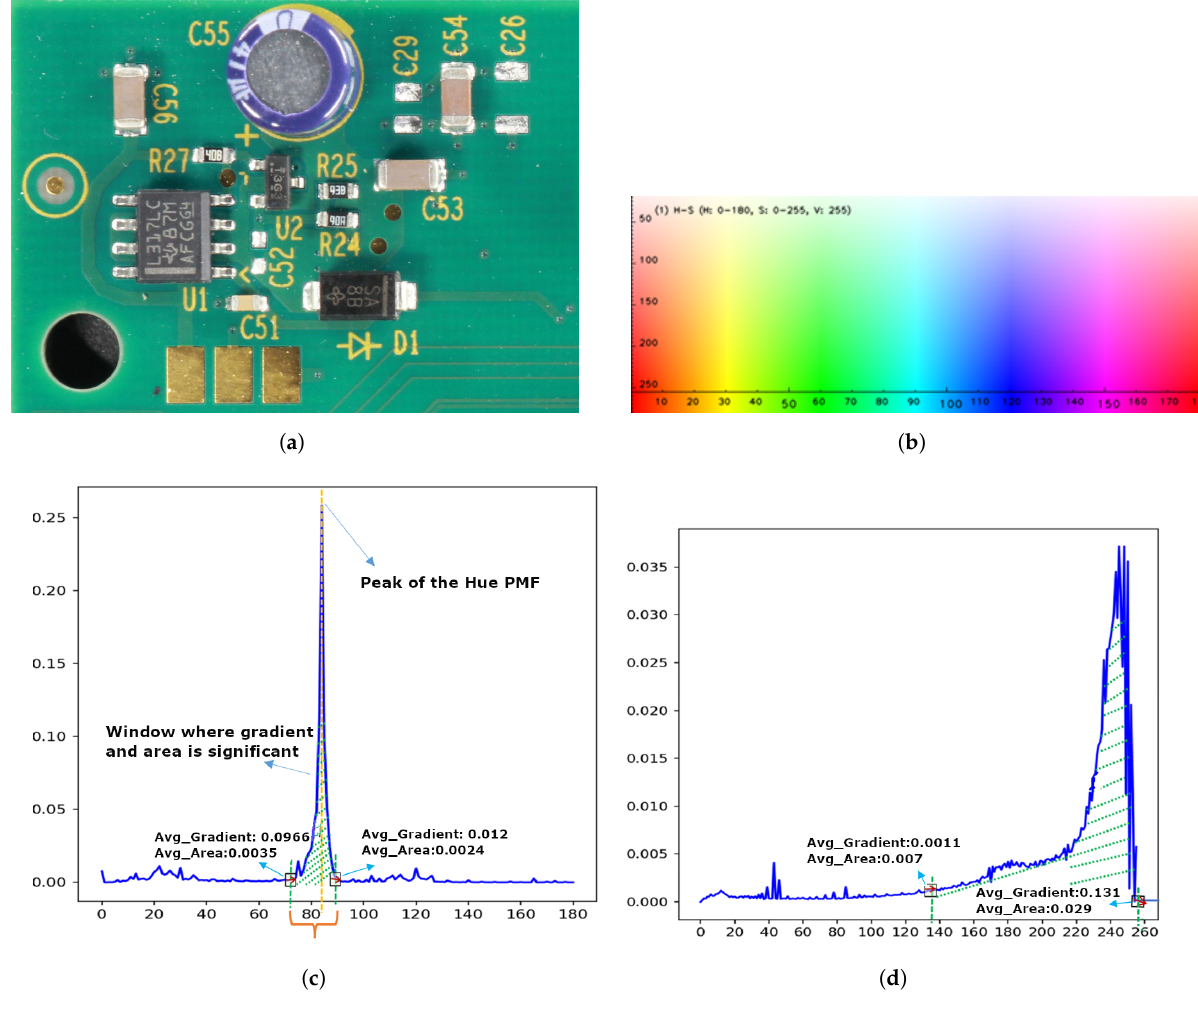
Figure 2. ( a ) Input color image. ( b ) Hue and saturation representation for the HSV format in OpenCV. The hue ranged from 0 to 180, the saturation ranged from 0 to 255, and the value was fixed at 255 for this representation. ( c ) The probability mass function of the hue component (symmetric unimodal histogram) of the input image. The nominated hue ranges were 18 to 35, 72 to 93, and 116 to 130, where the area under the curve and gradient were greater than a cut-off value within a window. The shaded region (72 to 93) shows the optimal global hue range selected by the proposed algorithm according to the maximum continuous hue range heuristic, including the peak hue at position 83. ( d ) The probability mass function of the saturation component of the input image (skewed unimodal histogram). The nominated saturation ranges were 30 to 55, 75 to 90, and 137 to 255, where the area under the curve and gradient were greater than a cut-off value within a window. The shaded region (137 to 255) shows the optimal global saturation range selected by the maximum continuous saturation range heuristic. The small black box indicates the window, and the red arrow represents the gradient value in the corresponding